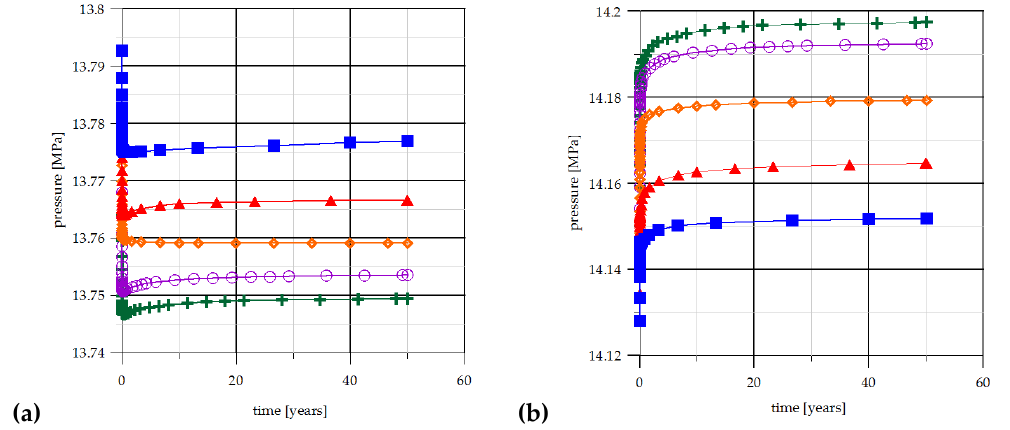
Figure 5. Variants of calculation grid density calculation. Areas of grid blocks: A —1 m 2 , B —10 m 2 , C —100 m 2 , D —1000 m 2 , E —10,000 m 2 .